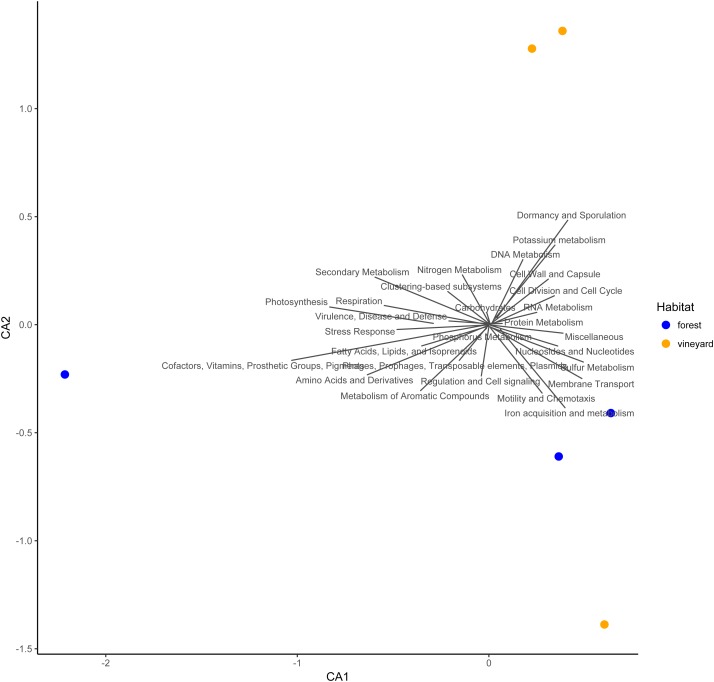
Ordination plot for metabolic categories in soils.Ordination plot from the canonical correspondence analysis (CCA) based on the relative abundances (points) and component loadings (text) of individual functional categories (SEED subsystem level 1) of the microbial communities found in forest and vineyard soils.